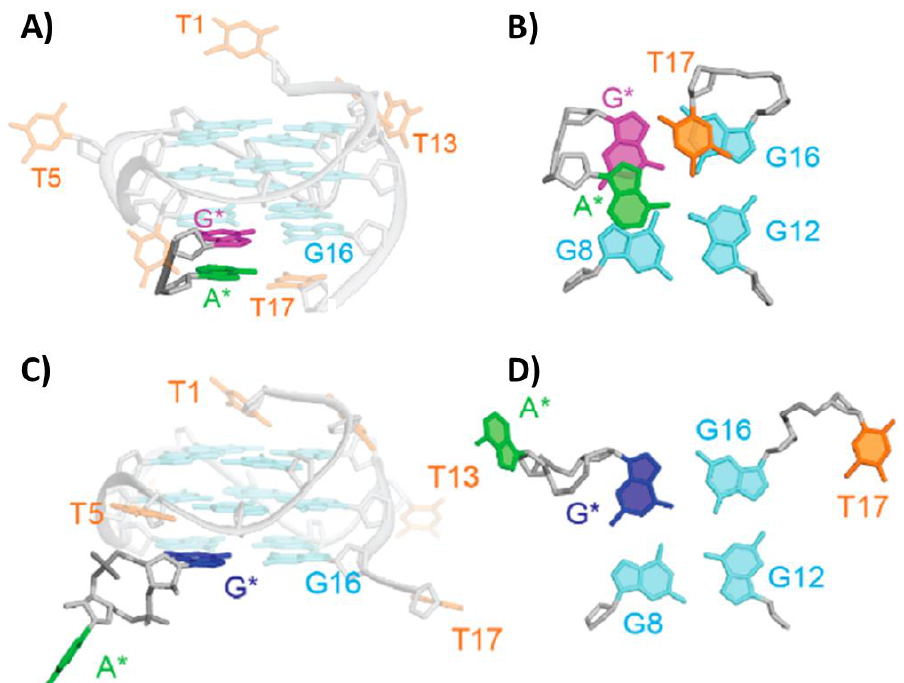
Figure 7. NMR structure of the complex between the unimolecular parallel G-quadruplex o-tel17 of sequence d[TTGGT(GGGT) 3 ] and ( A ) d(AG) or ( C ) cGAMP. 5′ - and 3′ -ends of the G-quadruplex are at the top and bottom, respectively. Details of the ligand binding are highlighted in ( B ) for d(AG) and ( D ) for cGAMP. Adapted with permission from ref. [71], Copyright 2019 American Chemical Society.